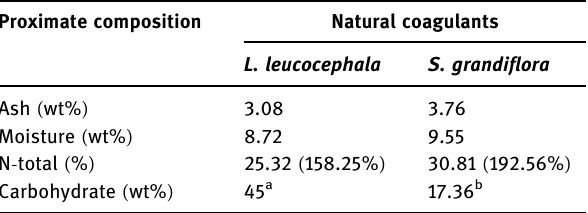
Table 1: Proximate composition of natural coagulants used in this study Proximate composition Natural coagulants